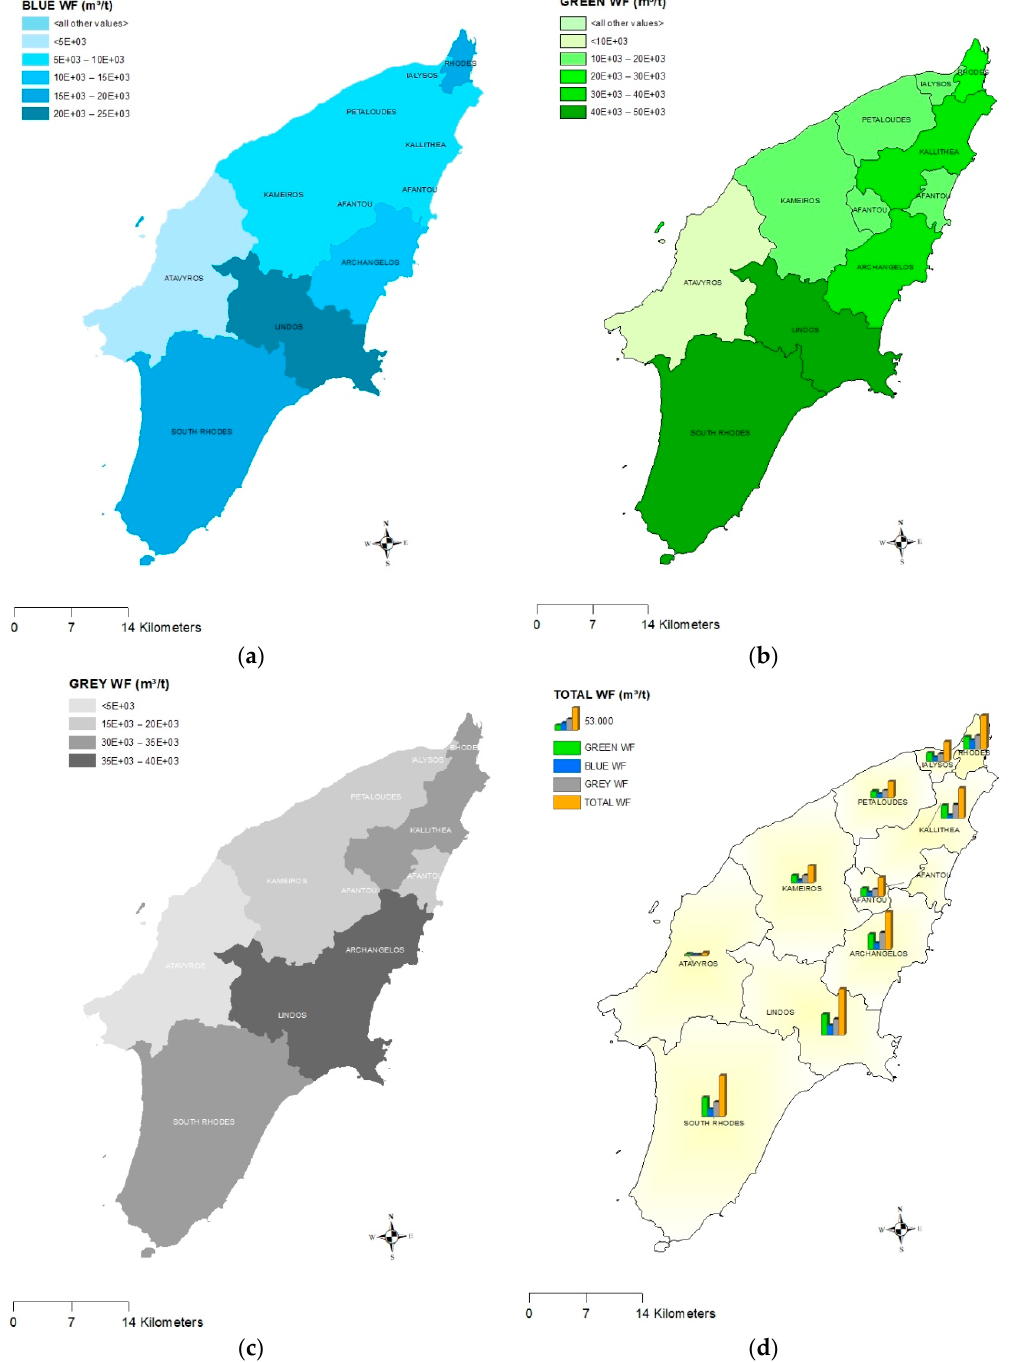
Figure 4. Distribution of WF (m 3 t − 1 ) for 2013 per MU: ( a ) blue WF; ( b ) green WF; ( c ) gray WF; and ( d ) total WF.